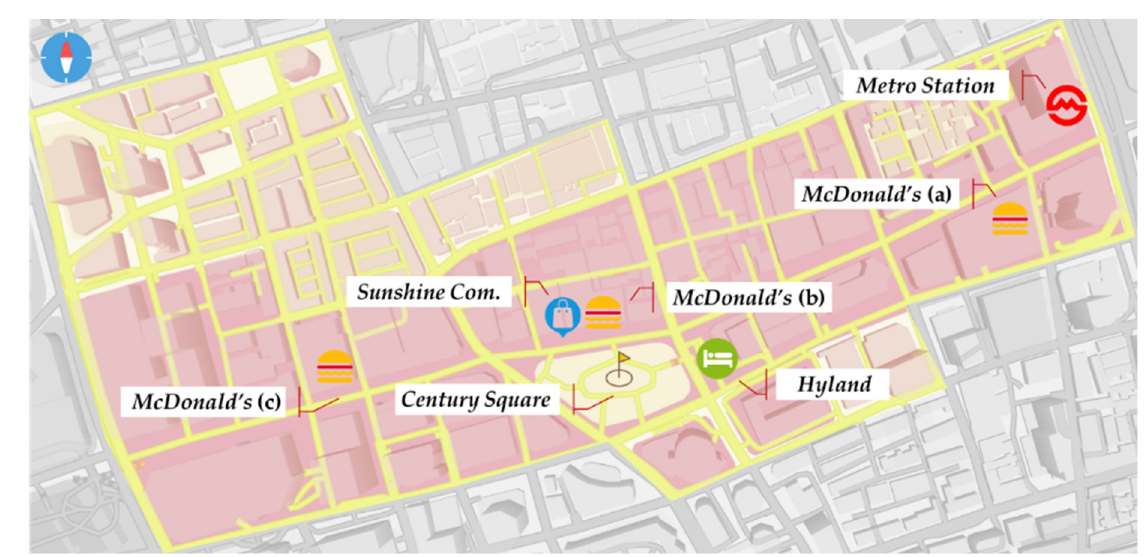
Figure 7. Nanjing Road Walkway and some landmarks.